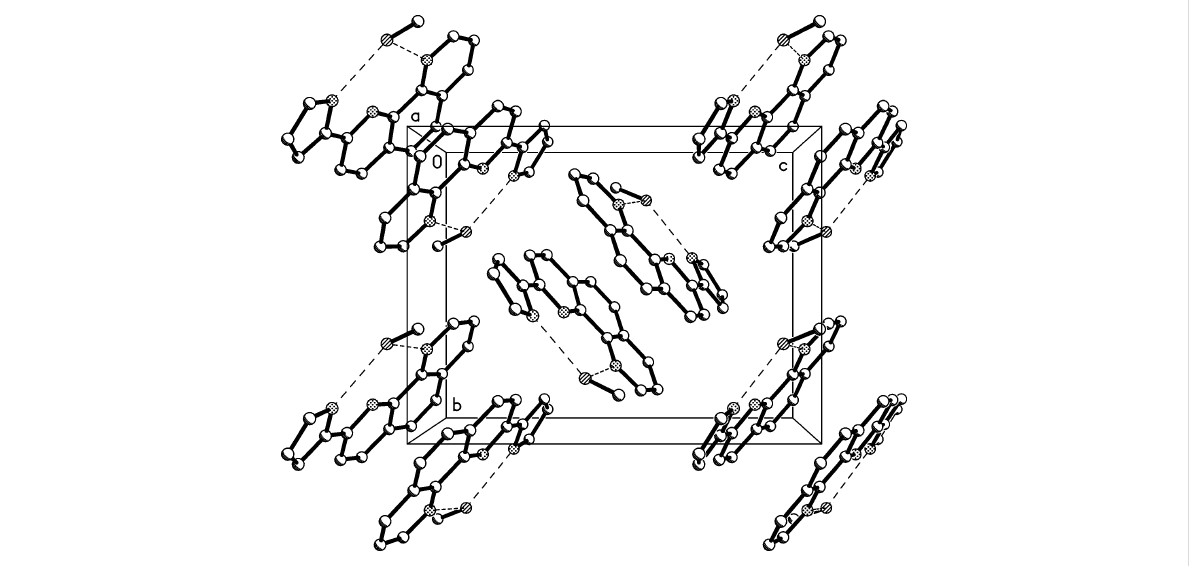
Figure 4: Packing diagram of compound 2 ·CH 3 OH showing the formation of inversion-symmetric "stacked" dimers. Hydrogen bonds are shown as thin dashed lines. Hydrogen atoms are omitted for clarity.